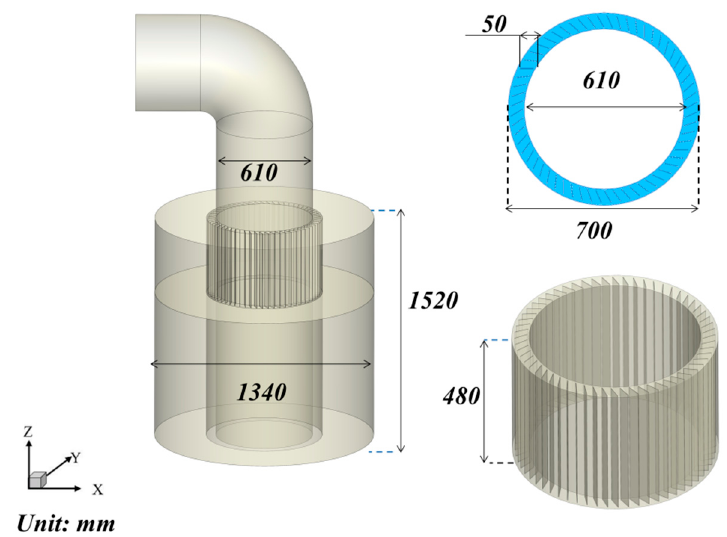
Figure 4. The structural dimensions of the turbo air classifier.